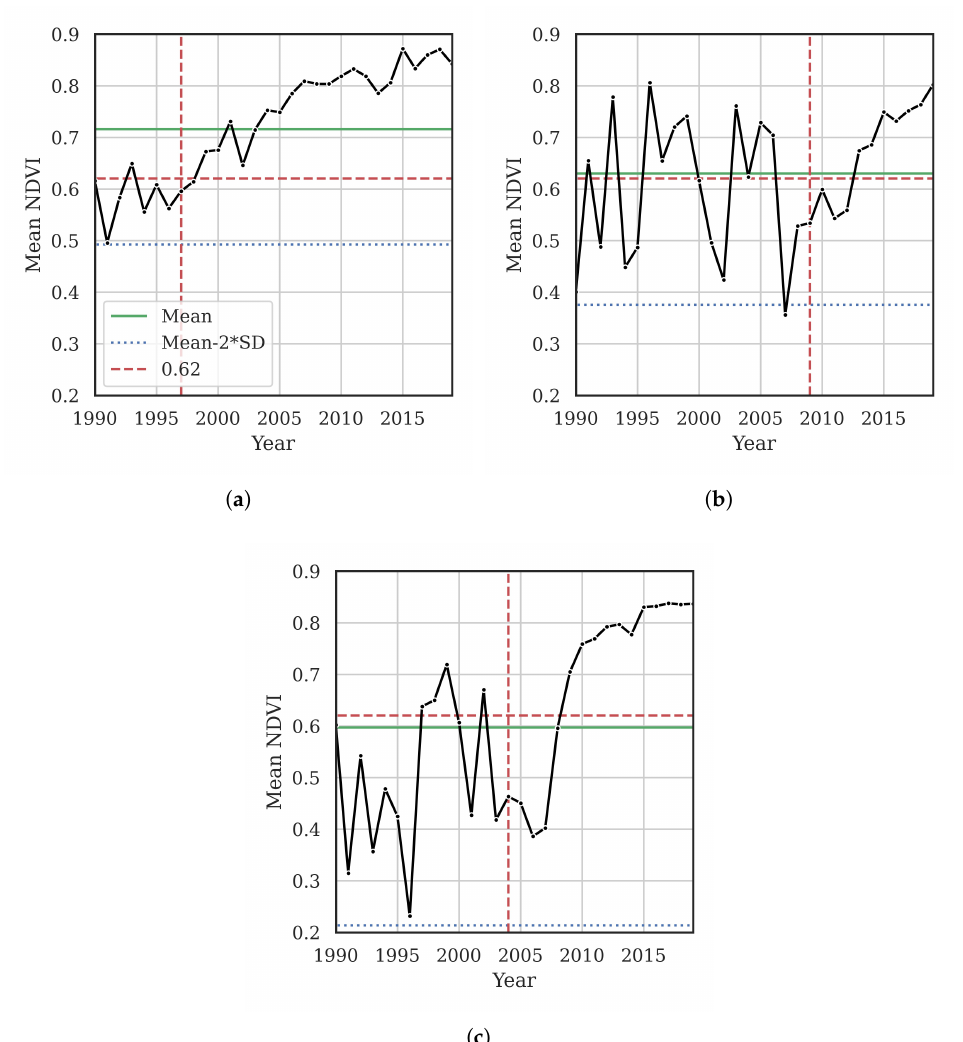
Figure 3. Mean NDVI per year for three macadamia blocks. Actual planting year is indicated by the vertical red line, the selected threshold of NDVI mean = 0.62 by the horizontal red lines, time-series mean by the green lines, and mean − 2 × SD by the blue lines. One example from each of the three regions is shown: ( a ) Macksville, ( b ) Ballina, and ( c )